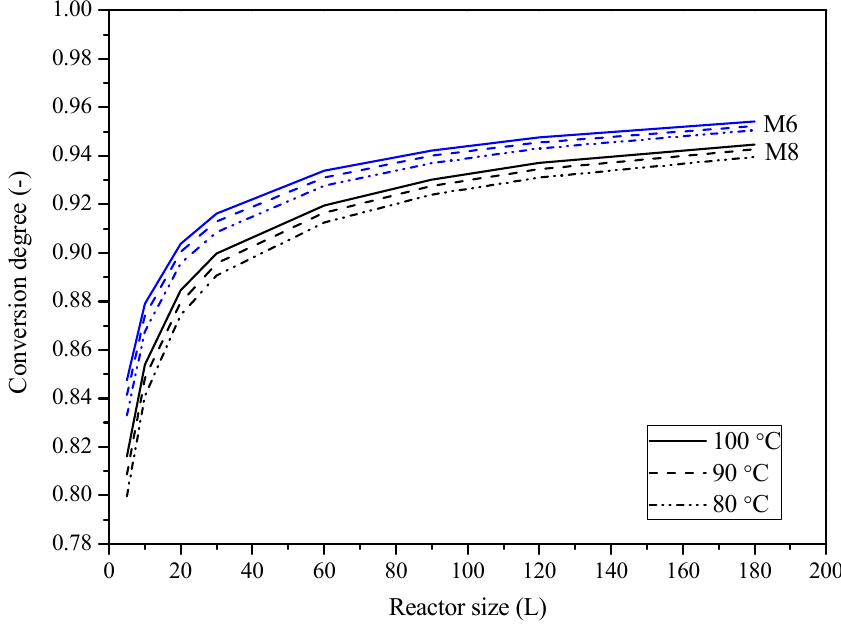
Figure 8. Desorption conversion degree using three different heating temperatures.